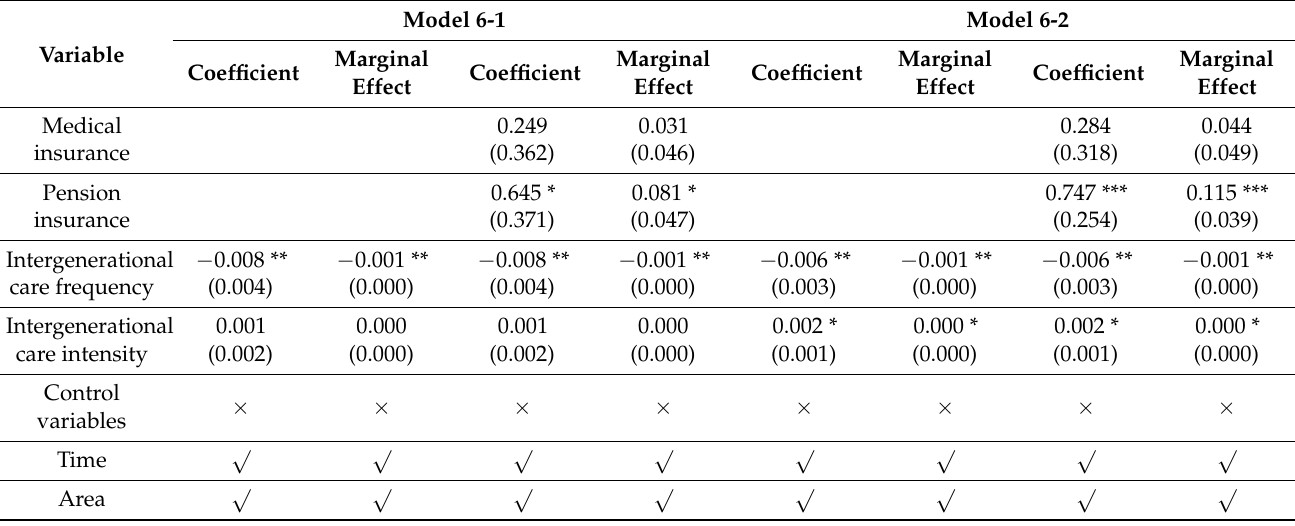
Table 6. Results of the sub-residence test of the sample data.